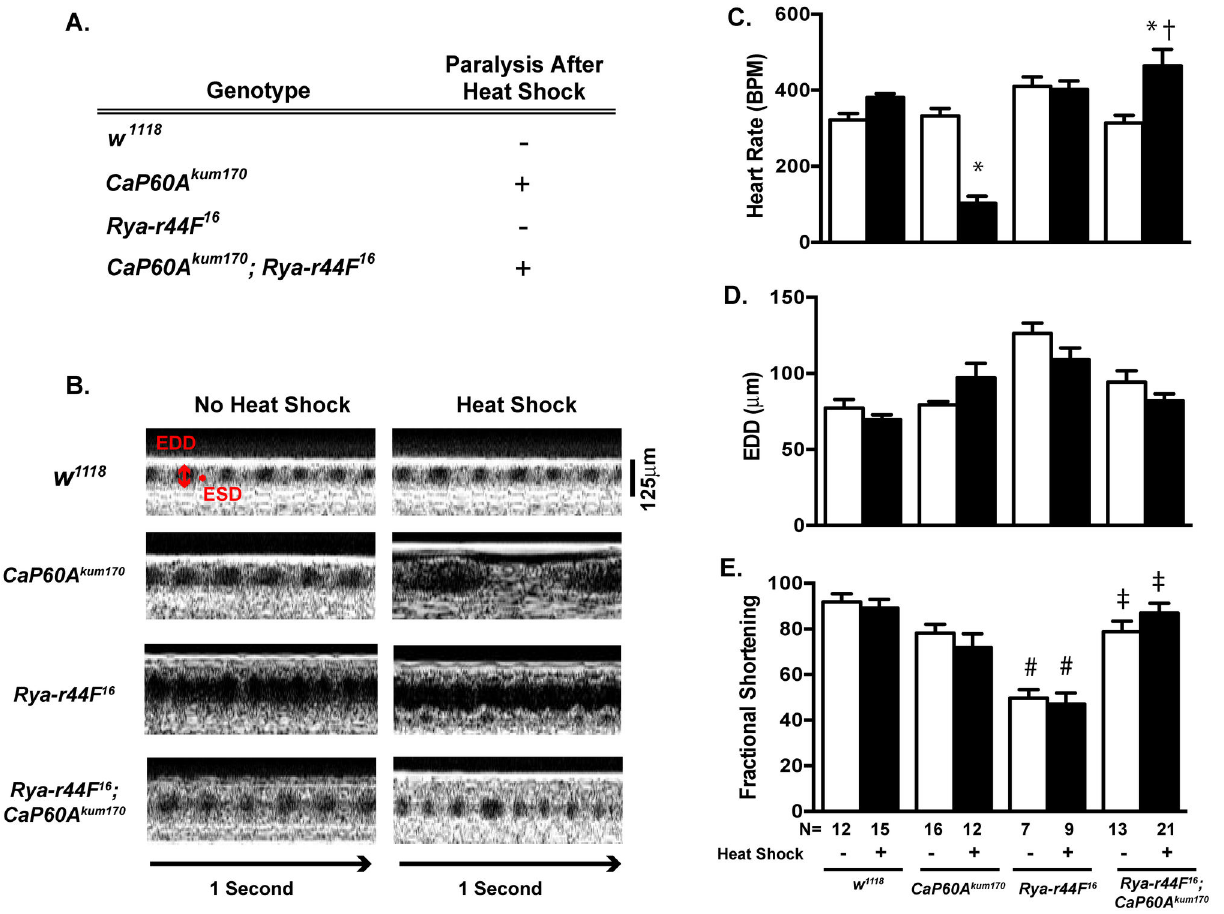
Figure 3. The effects of Calcium Release mutations on the CaP60A kum170 cardiac phenotypes. A . Heat shock induced paralysis in heterozygous CaP60A kum170 flies as well as in transheterozygous mutants carrying both CaP60A kum170 and a mutation in Ryanodine receptor ( Rya-r44F 16 ). No heat shock induced paralysis was noted in the single Rya-r44F 16 mutants or w 1118 . B . Representative OCT images from w 1118 , CaP60A kum170 , Rya-r44F 16 , CaP60A kum170 ; Rya-r44F 16 with and without 10-minute heat shock; A 125 micron standard and one-second bar are shown. EDD= End diastolic dimension, ESD=End systolic dimension. C . Heart rate, D. EDD and E . Fractional Shortening (%) in w 1118 , CaP60A kum170 , Rya-r44F 16 , CaP60A kum170 ; Rya-r44F 16 at baseline and after 10- minute heat shock. *p<0.0002 vs. non-heat shock state of the same genotype, † p<0.0001 vs. CaP60A kum170 after heat shock, #p<0.0001 vs. w 1118 of the same treatment condition, ‡p<0.0002 vs. Rya-r44F 16 of the same treatment condition by one-way